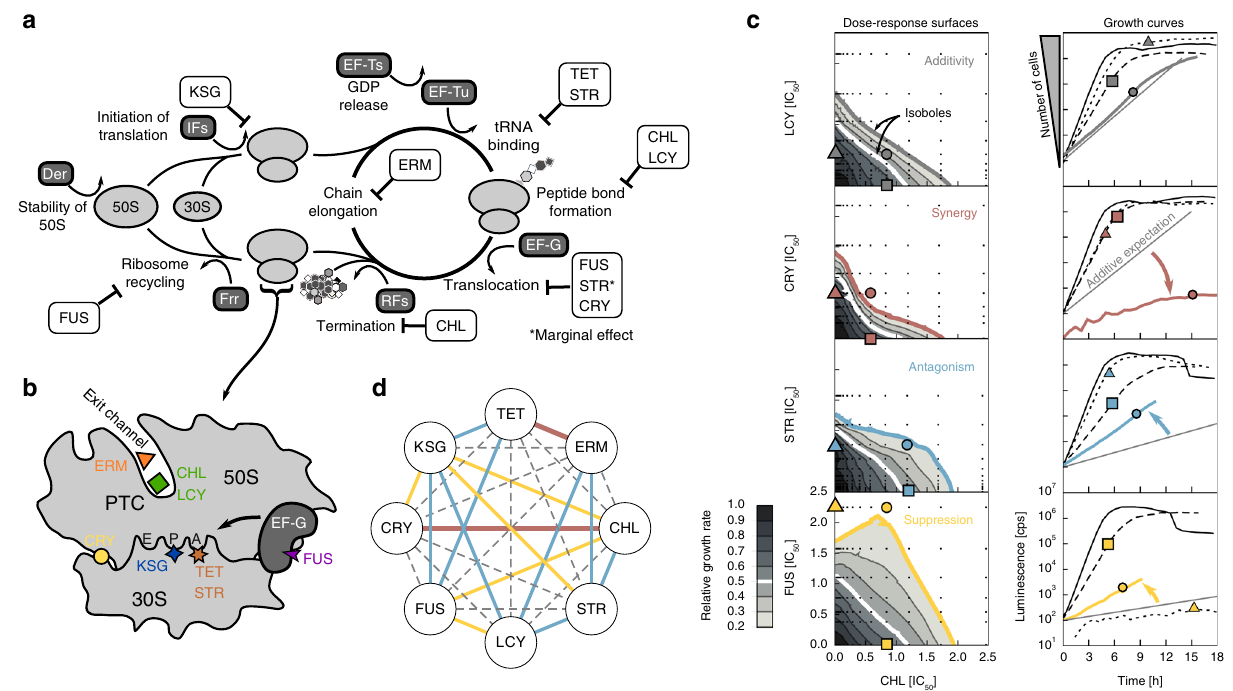
Fig. 1 Antibiotics targeting different translation steps show diverse drug interactions. a , b Schematic of the translation cycle and translation inhibitors. Translation factors are shown in dark gray boxes. The stability of the large subunit is mediated by Der and initiation by initiation factors (IFs). Elongation factors Tu and G (EF-Tu, EF-G) catalyze ribosome progression. The release of GDP from EF-Tu is facilitated by EF-Ts. Release factors (RFs) facilitate the ejection of the fi nished peptide from the ribosome, whose recycling is mediated by the factor for ribosome recycling (Frr). Translation inhibitors are shown in white boxes (abbreviations in Table 1). c Examples of response surfaces for different antibiotic combinations corresponding to different interaction types (left column) and examples of growth curves (right column). Left: dose – response surfaces for different drug combinations. Grayscale shows a normalized growth rate as a function of concentrations of two antibiotics. Drug interactions are determined based on the shape of the contour lines of equal growth (isoboles). If the addition of the second drug has the same effect as increasing the concentration of the fi rst, the isoboles are straight lines 12 . Deviations from this additive expectation reveal synergism (the combined effect is stronger and isoboles curve towards the origin), antagonism (the effect is weaker and isoboles curve away from the origin), or suppression (at least one of the drugs loses potency due to the other). Symbols show drug conditions in which growth curves shown in the right column were measured. Right: Growth curves (i.e., time courses of luminescence) for four conditions (no drug, individual drugs, and combination); thin gray line shows the additive expectation of the growth curve for the combined stress; luminescence (photon count-per- second) on y-axes is a proxy for the number of bacteria (Methods). Symbols on the growth curves indicate the condition used: no symbol, triangle, square and a circle correspond to no drug, CHL-only, the second drug only (see left plots), and the combination of both, respectively. The growth curves were shifted in time to originate from the same point at time zero. d Drug-interaction network of translation inhibitors. Color-code is as in ( c ); dashed gray lines denote additivity. Each drug interaction was measured